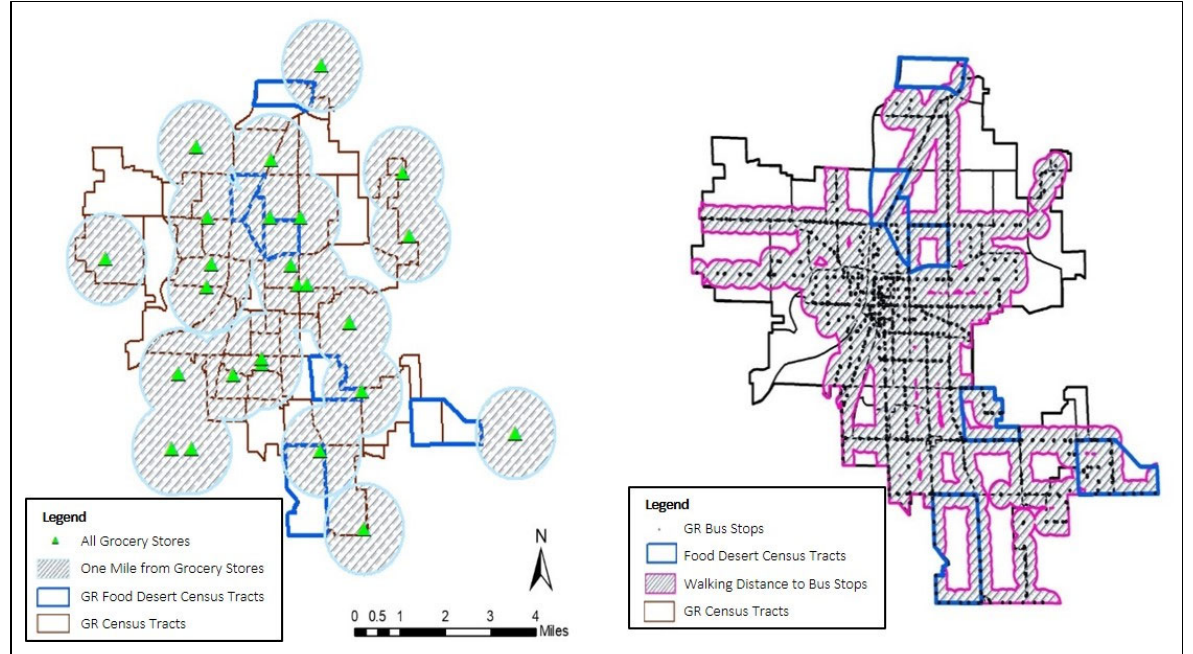
Figure 4. Areas within 1 Mile of a Grocery Store(Left) and 5 Minutes of a Bus Stop